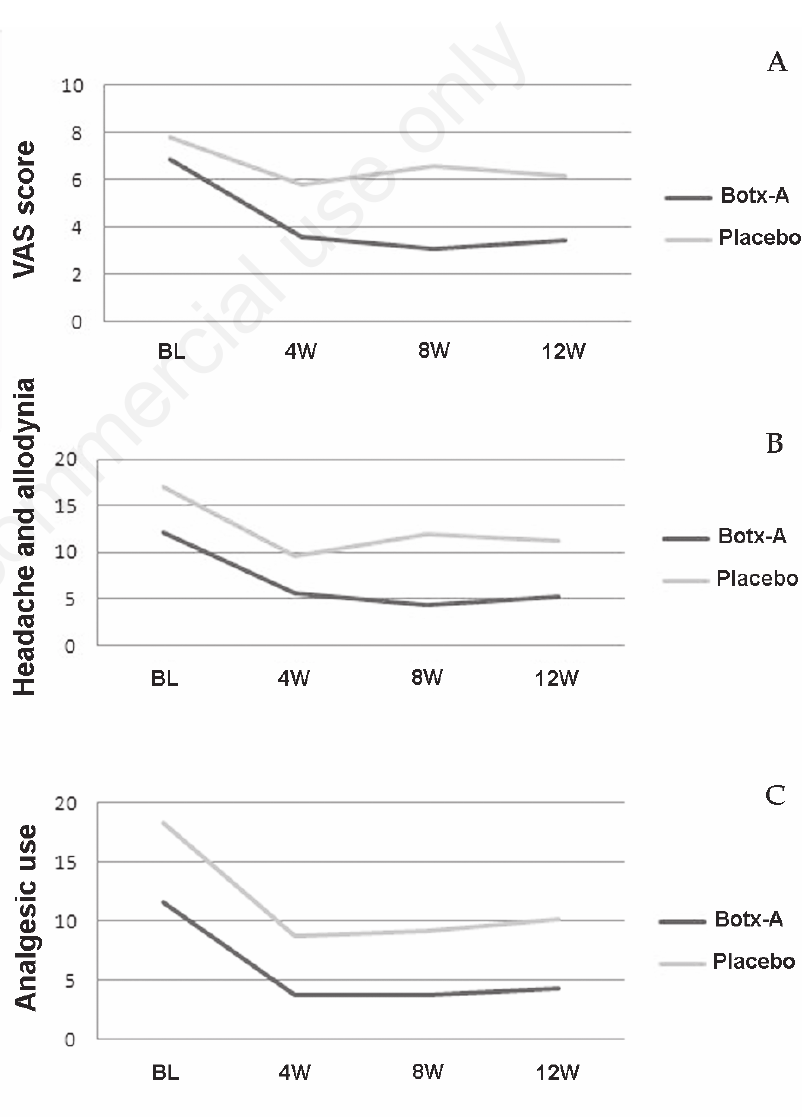
Figure 1. Mean change from baseline to end-of-study in visual analogical scale scores (A), frequency of headache episodes associated with allodynia (B) and frequency of analgesic use for headache